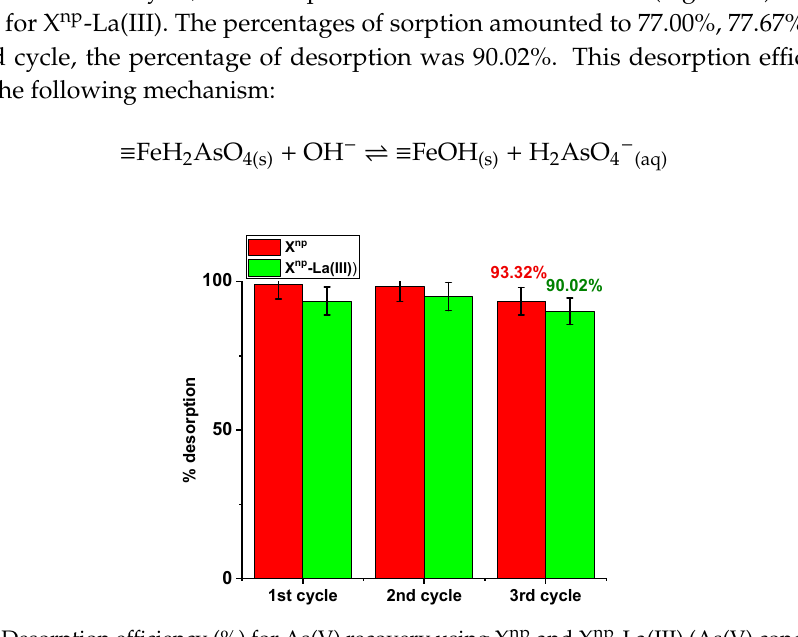
Figure 16. Desorption efficiency (%) for As(V) recovery using X np and X np -La(III) (As(V) concentration: 100 mg/dm 3 , desorbing agent: 1M NaOH, sorption/desorption time: 6 h, shaking speed 180 rpm, temperature 295 K).